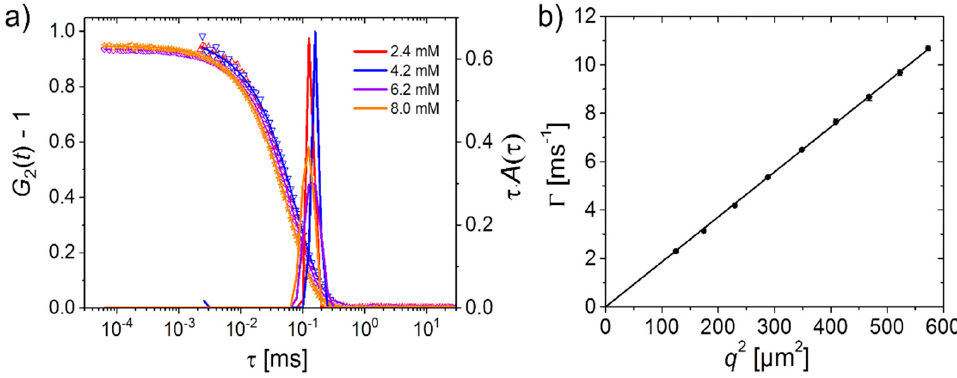
Figure 2. Representative results from DLS on a 5 wt.% solution of PSPP 280 in H 2 O. ( a ) Left axis: Intensity autocorrelation functions at θ = 90° and 30 °C in relation to NaBr concentration, as indicated in the graph. The time ranges of the curves differ because they were measured on two different instruments, see the Materials and Methods Section. Right axis: Corresponding distribution functions of relaxation times in equal area representation, τ A( τ ) vs. log( τ ); ( b ) Relaxation rate, Γ , of PSPP 280 in 1.4 mM NaBr in H 2 O at 25.3 °C vs. q 2 . Symbols: measured data, line: linear fit through the origin.